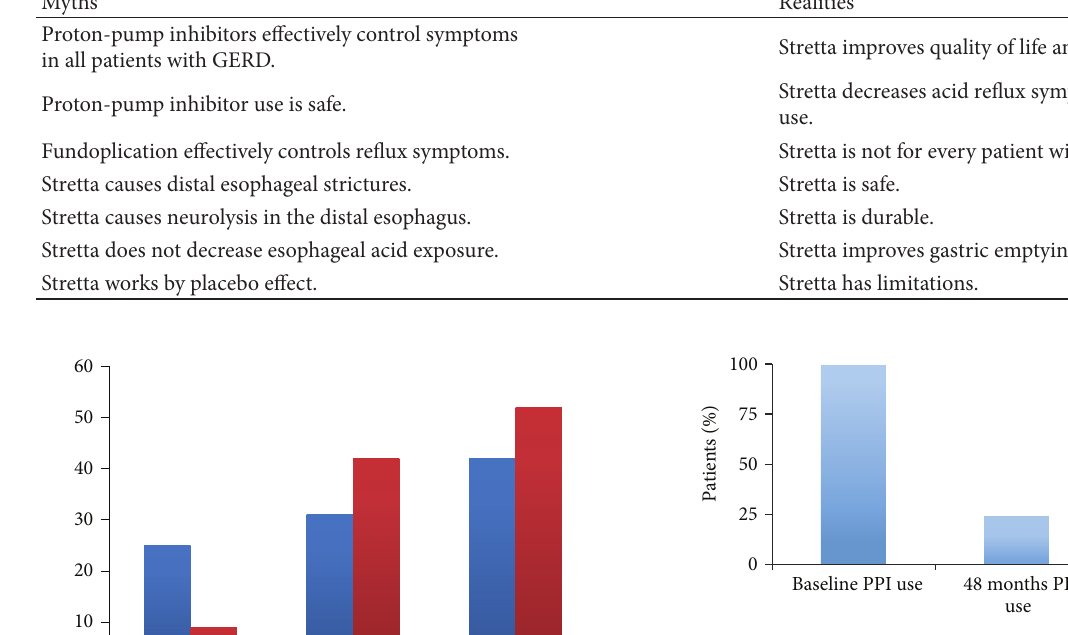
Figure 5: PPI and antacid use 48 months after